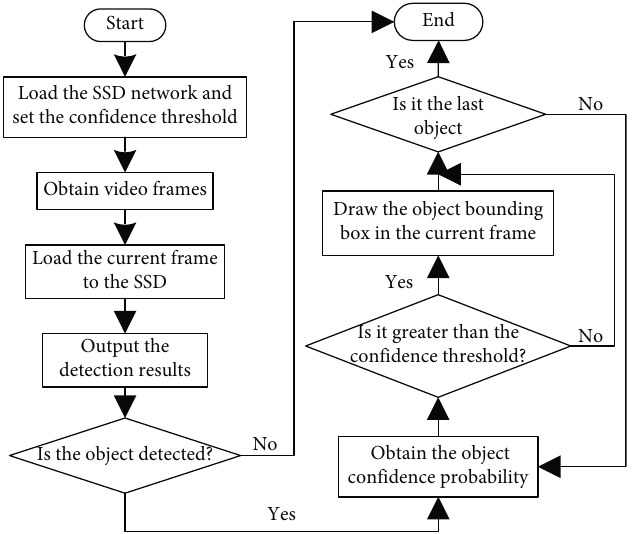
Figure 3: Human detection process based on MobileNet-SSD.